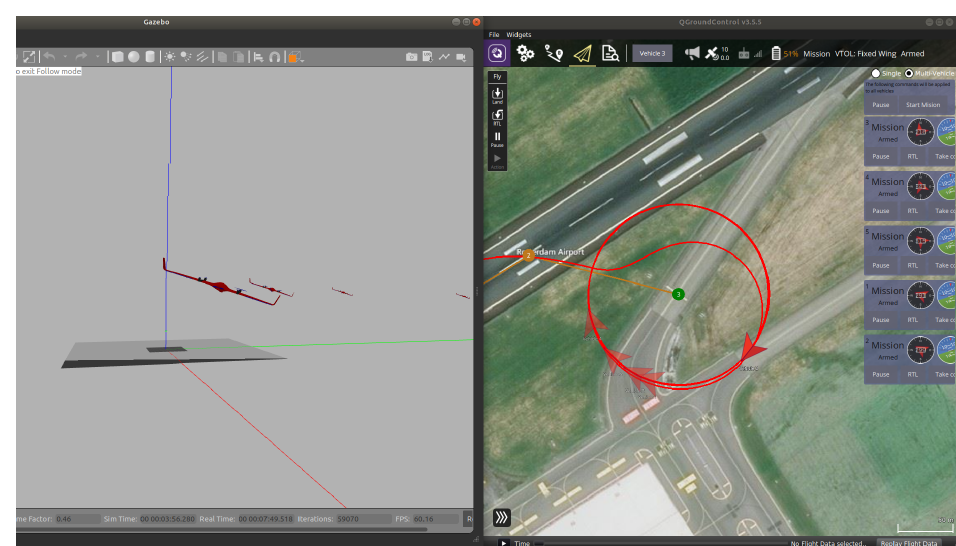
Figure 5. UAVs during flight and